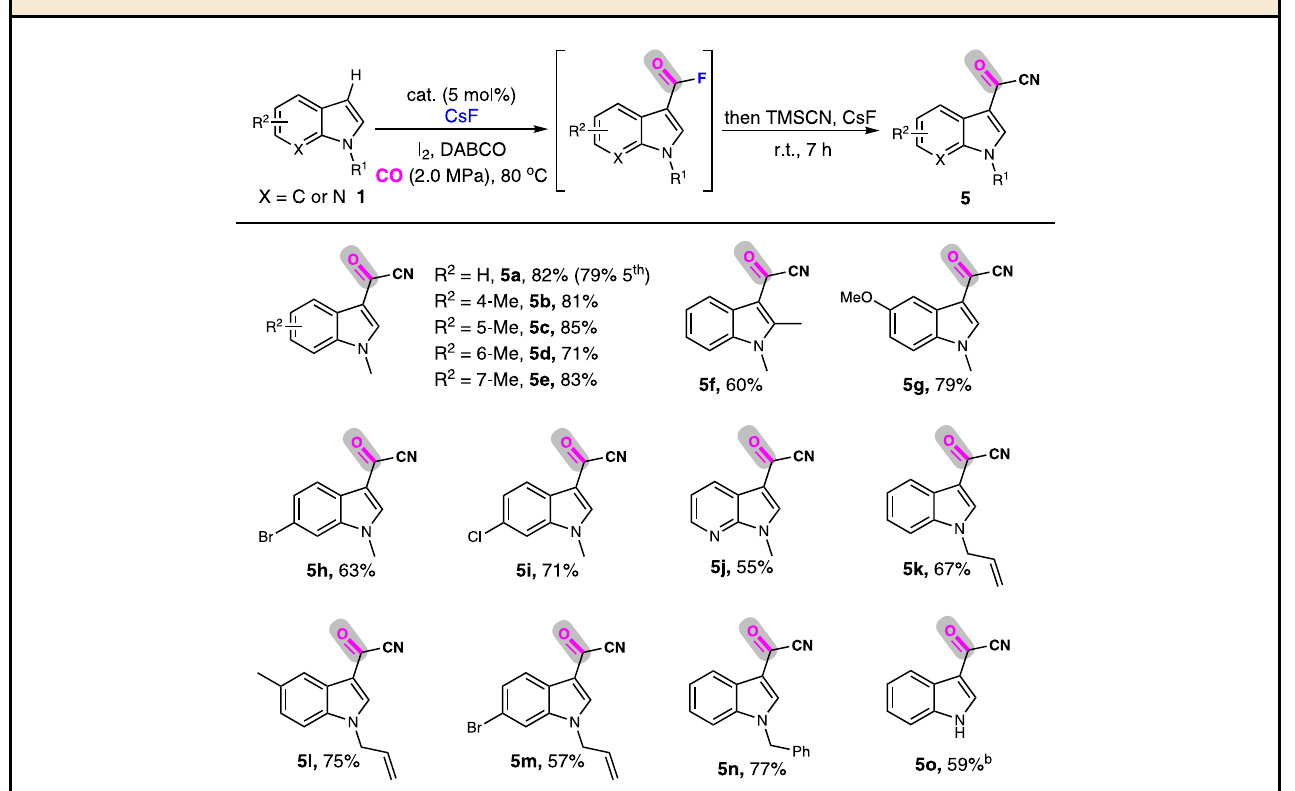
Table 4 Cyanocarbonylation of indoles and their analogues to synthesize indole-3-carbonyl cyanides a